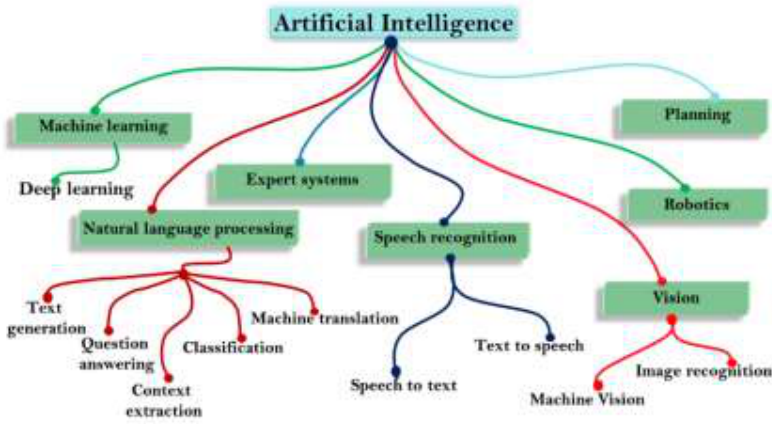
Figure 1. Artificial intelligence and its subfields (JavaTpoint, 2019)